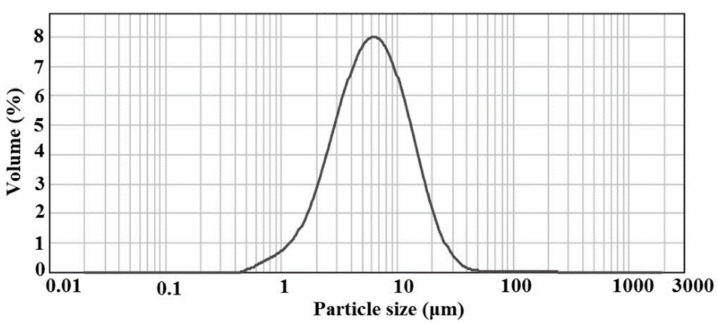
Figure 7. Particle size distribution of [C 3 mim] + Cl − @SiO 2 .